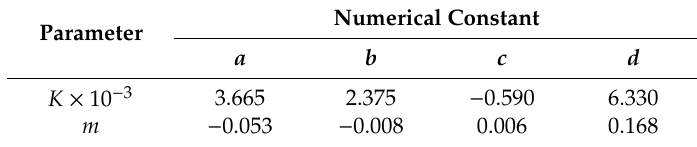
Table 2. Parameters of Equation (1b) according to Equation (38) reported by Varela-Castro [135].